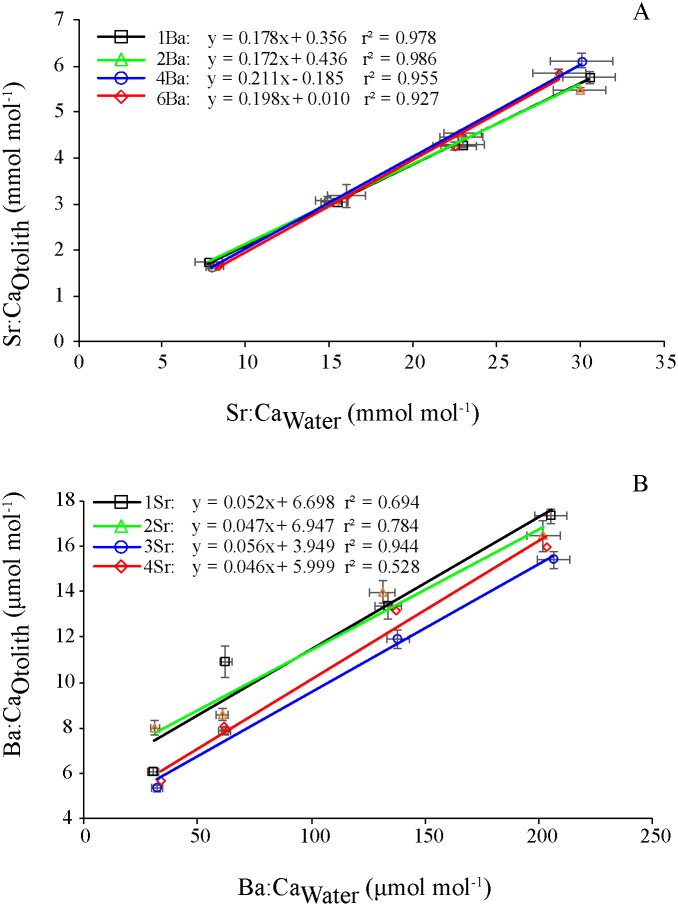
Relationship between Me:CaOtolith and Me:CaWater for Sr (A) and Ba (B).Lines were fitted by linear regression analysis at individual elemental concentrations. Data represent the mean values of Me:CaOtolith or Me:CaWater for each treatment.